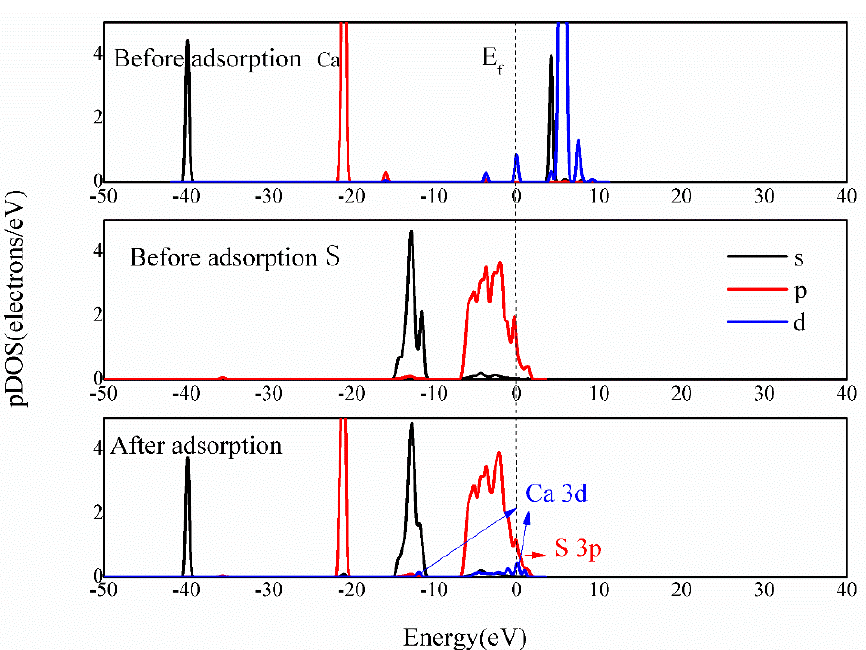
Figure 13. PDOS results of S and Ca before and after CaOH + adsorbed on molybdenite (100) surface.